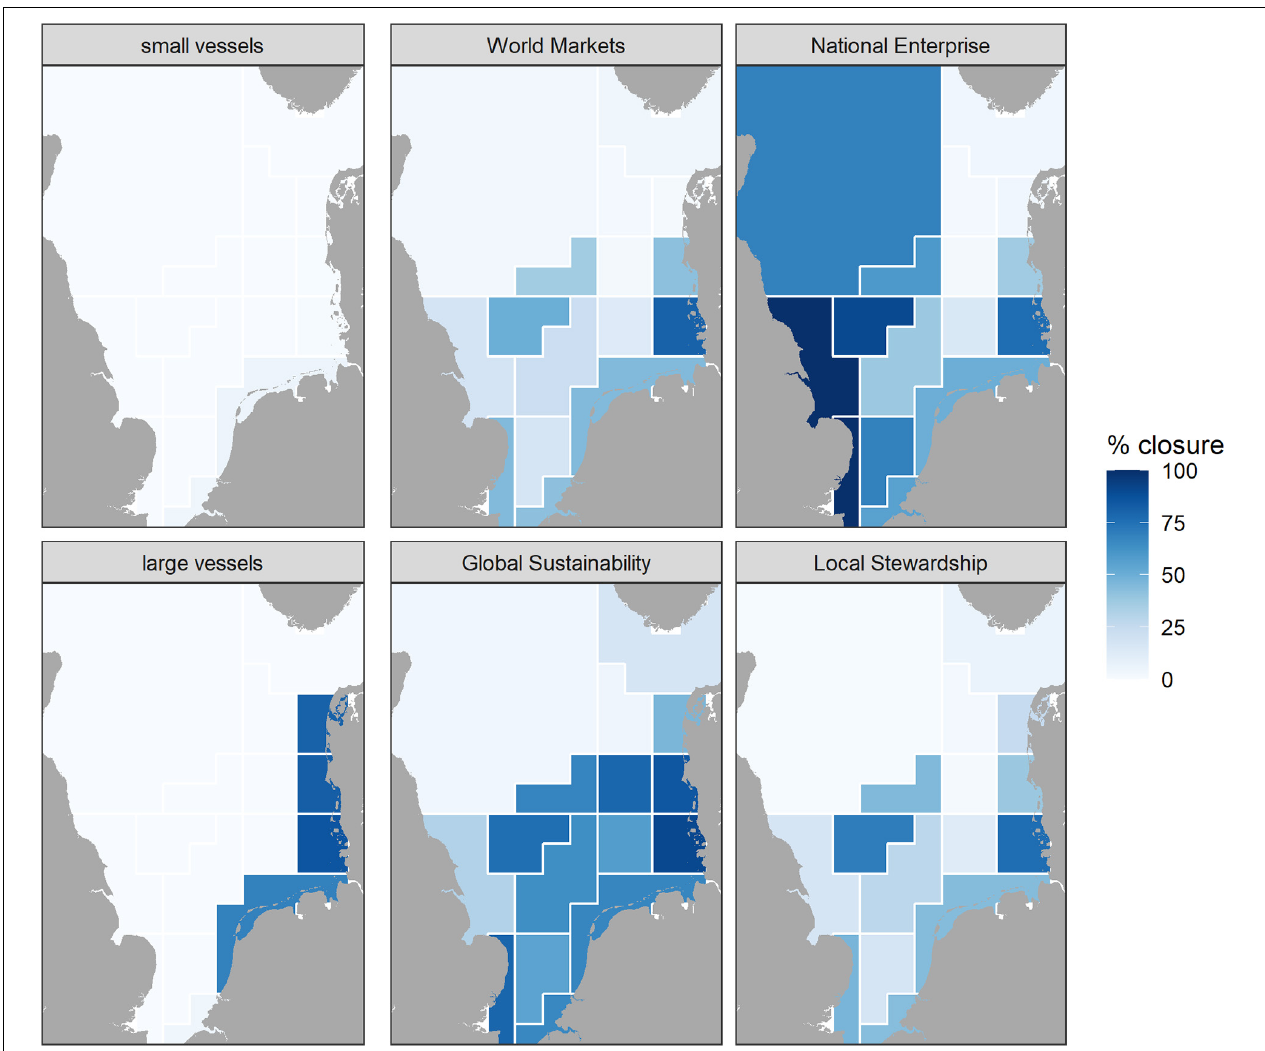
FIGURE 4 | Current area closures for large and small vessels (left panels) and scenario specific mid-century area closures in the North Sea for small vessels with bottom contact gears operating from the EU mainland (i.e., excluding the UK). Note the current closure of the plaice box for large beam-trawlers is also maintained for those fleets in the future and should be combined with small vessels closures (not shown